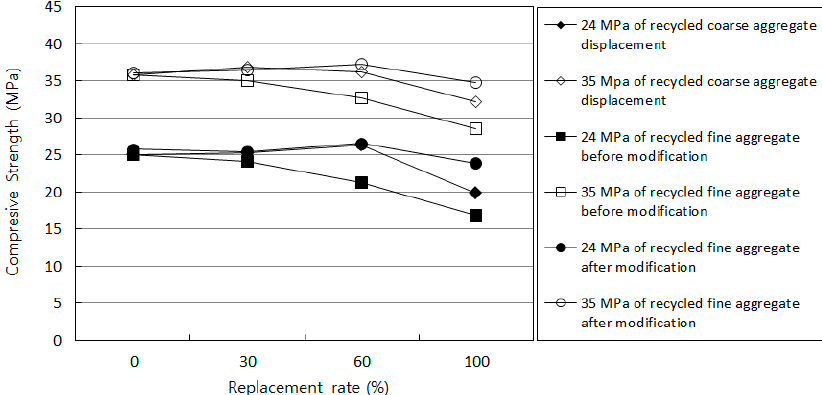
Figure 11. Compressive strength for strength area and replacement rate for recycled coarse aggregate replacement, recycled fine aggregate before modification, and recycled fine aggregate after